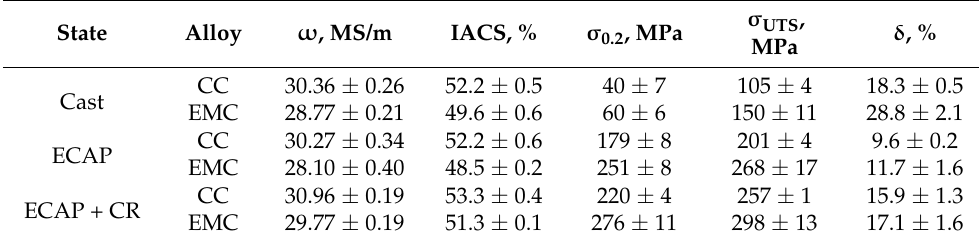
Table 4. Physical and mechanical properties of CC and EMC alloys after ECAP and CR.